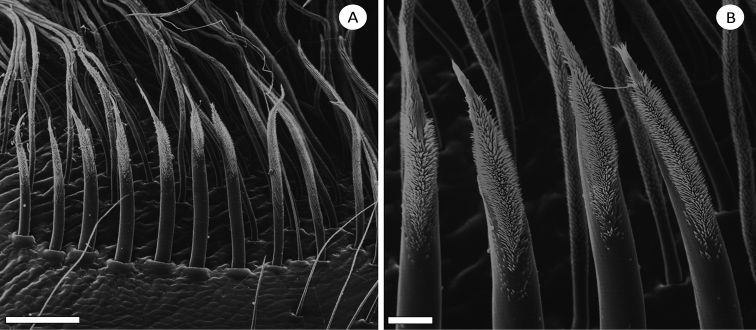
Lyra, proximal maxilla of PsalmopoeusA overview of the structure B detailed structure. Scale bar: 10 µm.